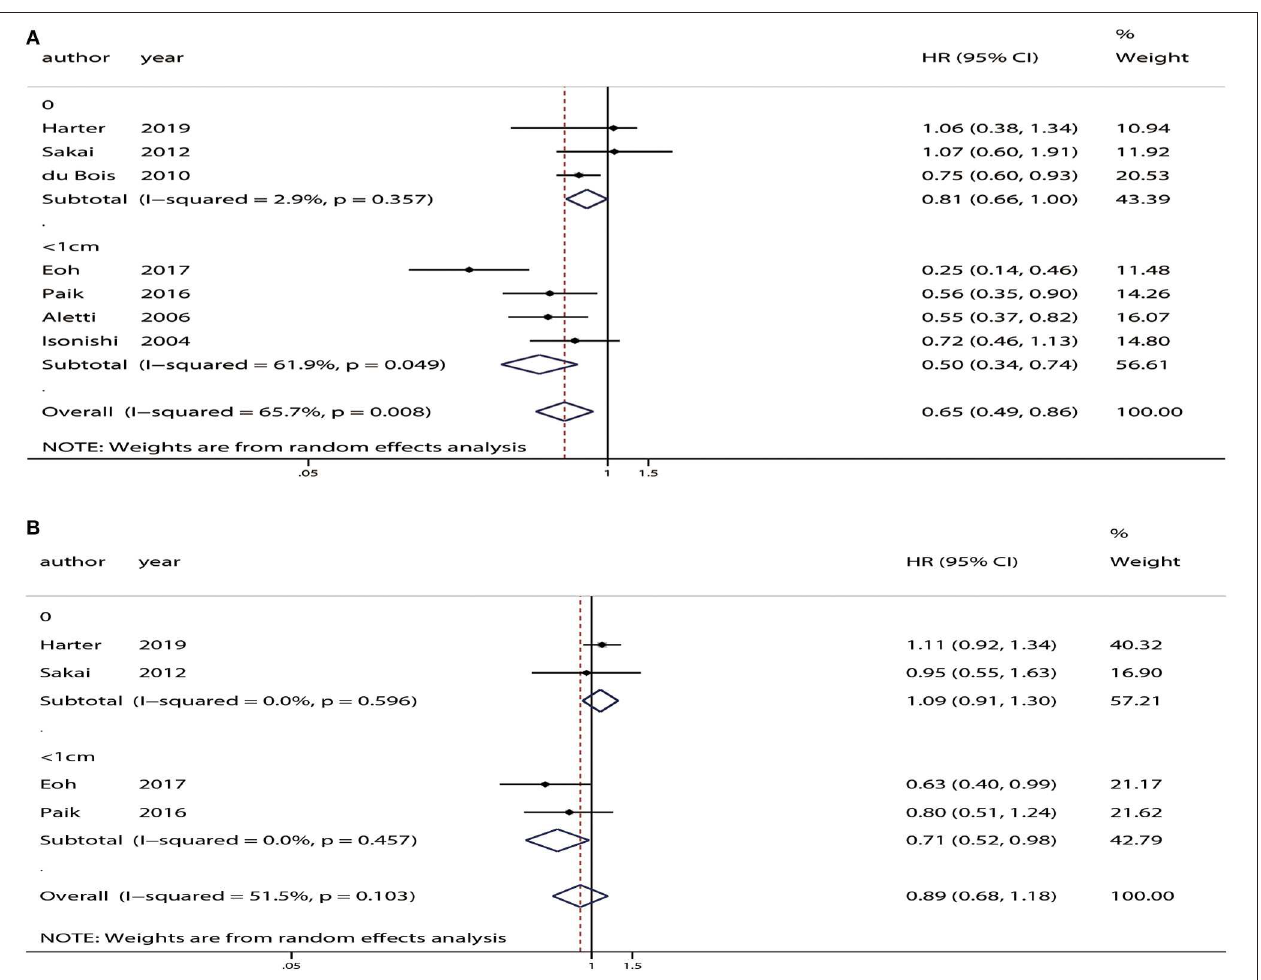
FIGURE 7 | Subgroup analyses based on residual tumor status in advanced ovarian cancer patients who underwent systematic lymphadenectomy vs. those who underwent unsystematic lymphadenectomy. (A) Overall survival (OS). (B) Progression-free survival (PFS).